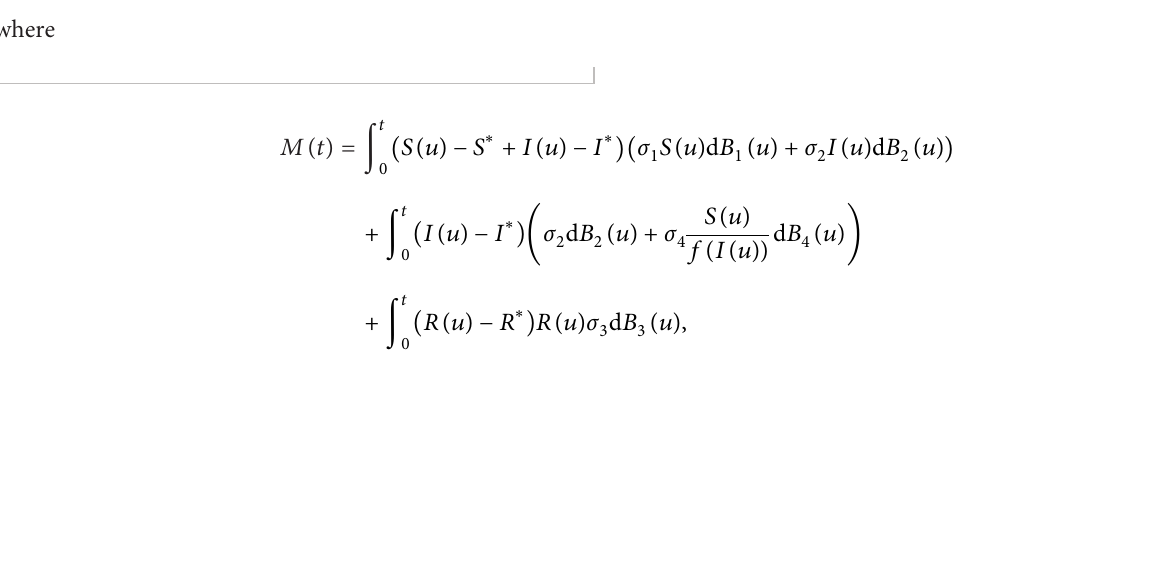
> 1. System (15) exists a unique stationary 0